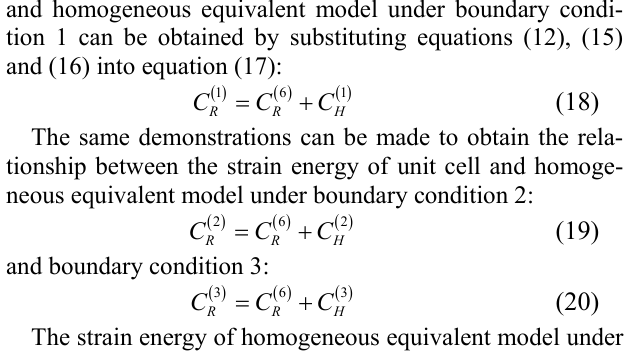
Fig. 7. Homogeneous equivalent model under boundary condition 5